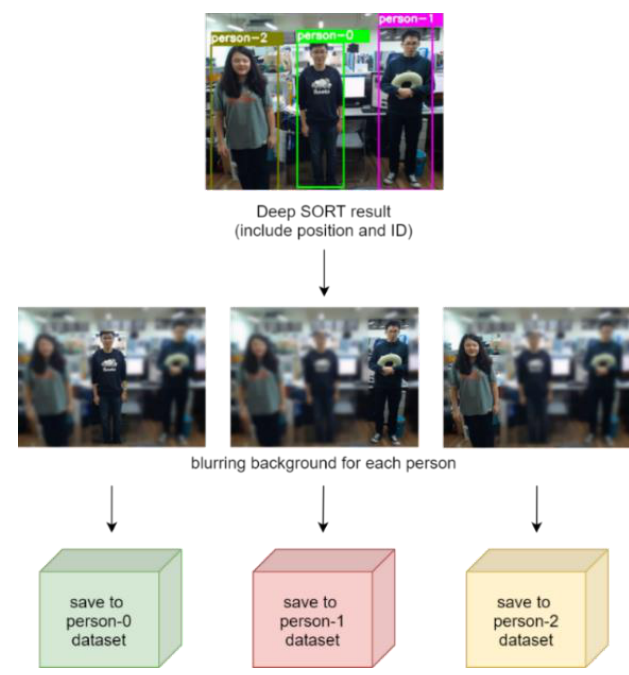
Figure 4. The process of blurring background.